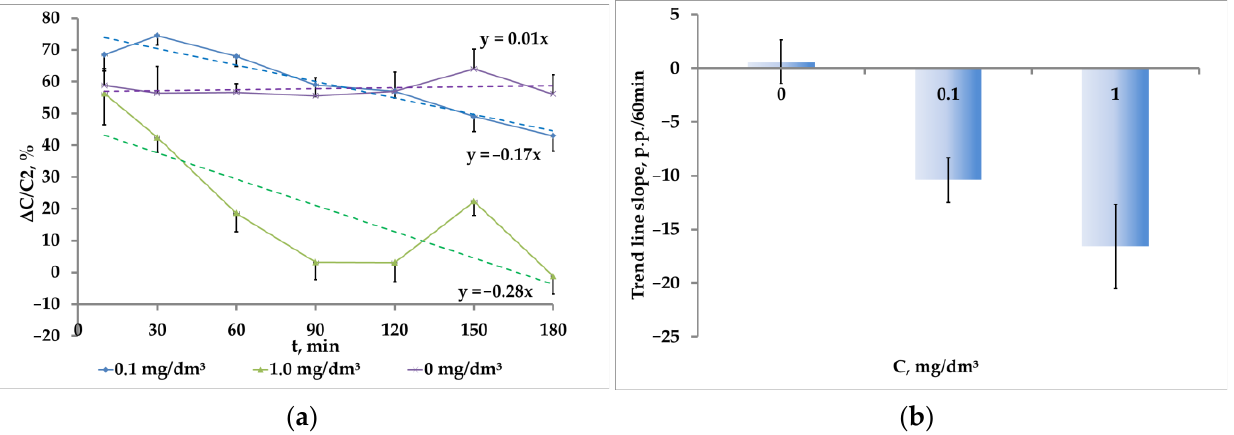
Figure 7. Approximation of ΔС/С 2 dynamics and ( a ) the slope of fitting lines ( b ) under the influence of various concentrations of nanoplastics on A. salina .